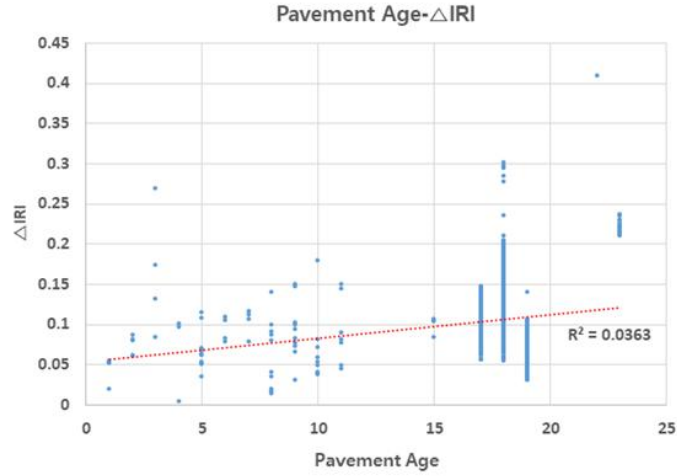
∆ IRI relationship.